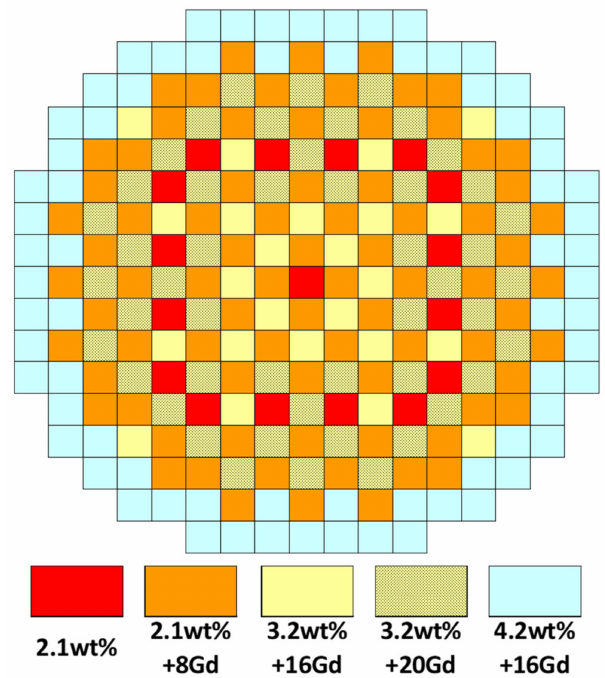
Figure 4. EPR whole-core initial fuel loading pattern with multiple enrichment zoning and gadolinia (Gd) poison pins